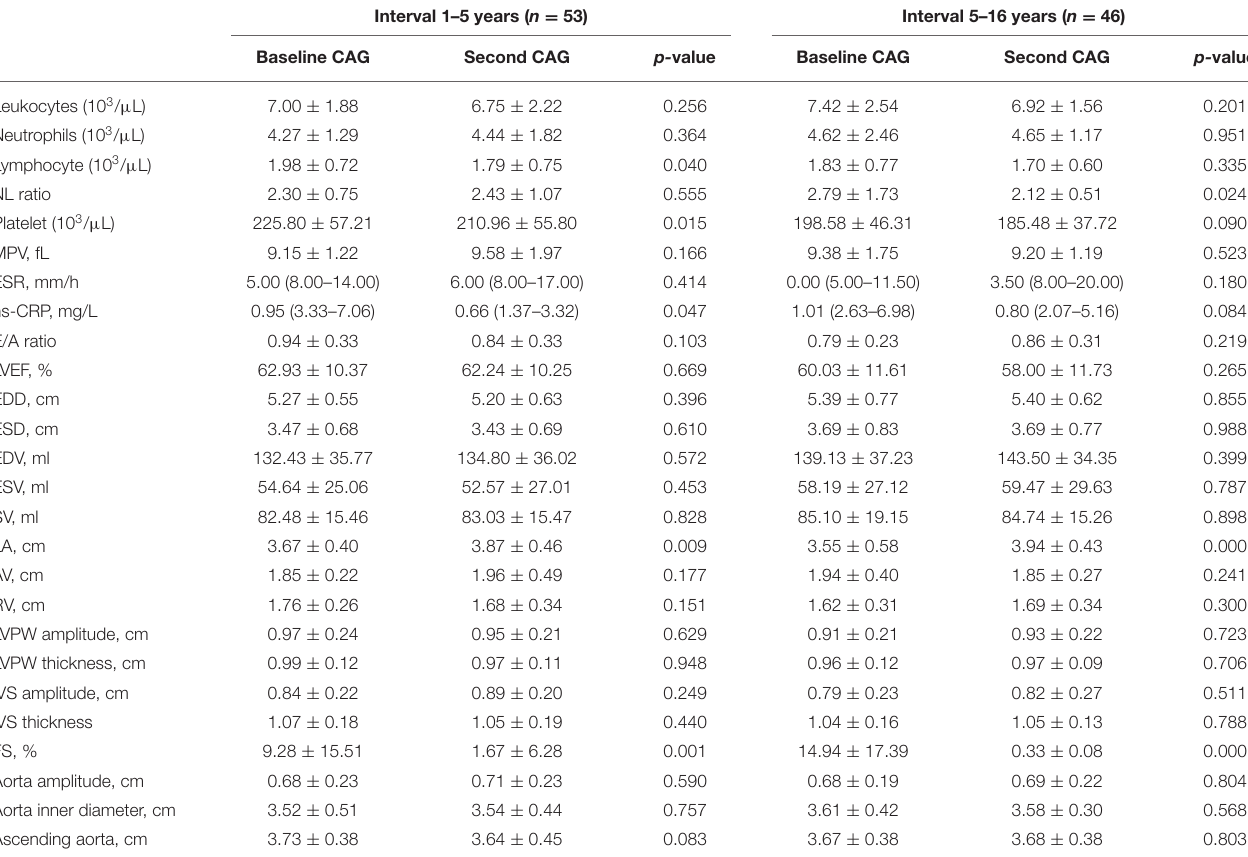
TABLE 2 | Inflammatory indicators and echocardiographic